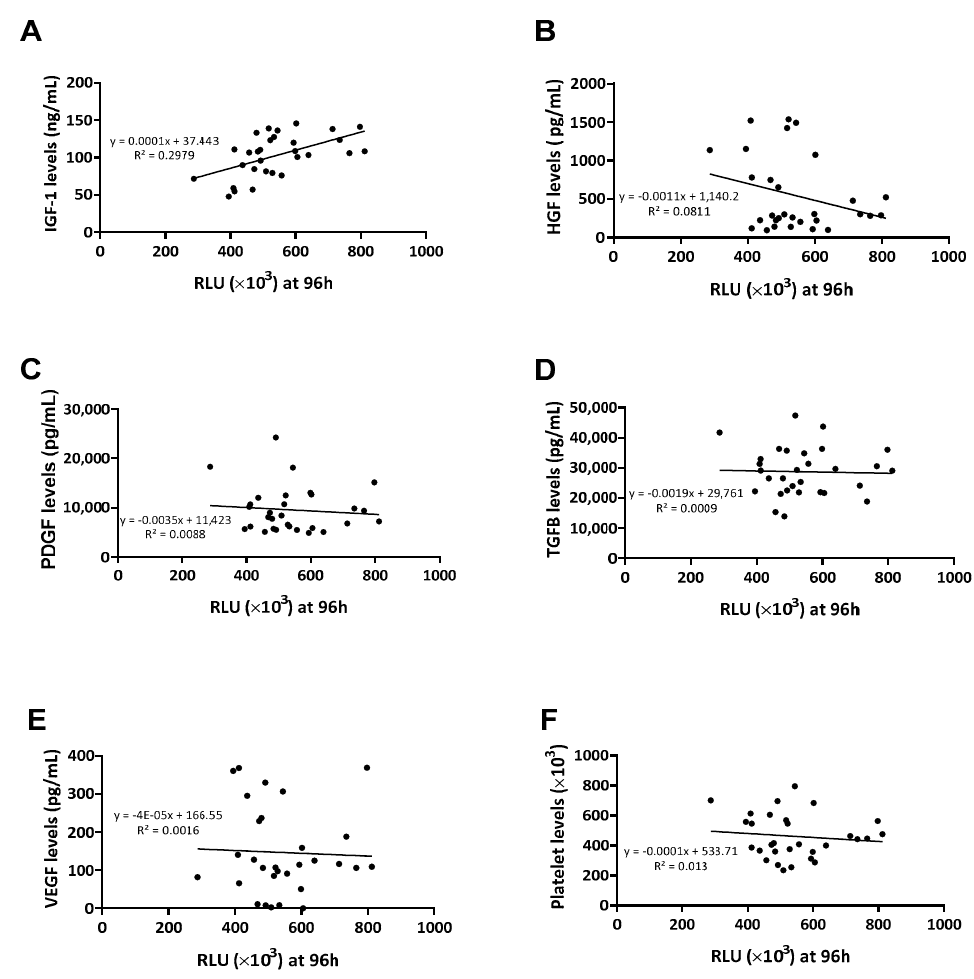
Figure 4. Correlations between growth factor levels and cellular viability. Cell viability was measured at 96 h and the RLU was correlated with IGF-1 ( A ), HGF ( B ), PDGF ( C ), TGF- β ( D ), VEGF ( E ), and platelet ( F ) levels measured by ELISA ( n = 30).